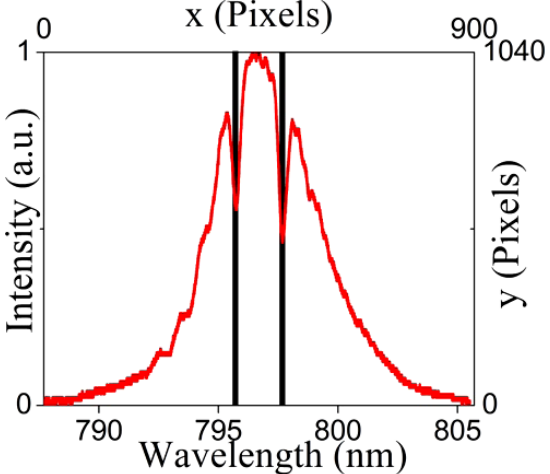
Fig. 2. (Color online) Calibration of the DUPS with Cartesian coordinate system de¯ned on the DMD; red curve: spectrum with modulation; black stripes: pattern with corresponding \o®" pixels on the